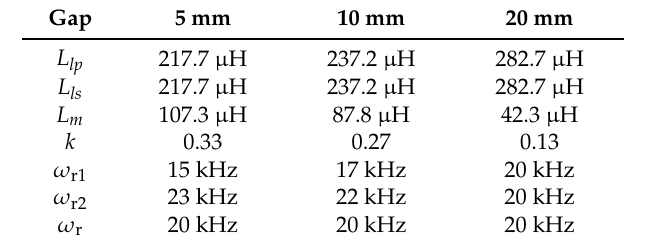
Table 1. Coupling coefficient and resonant frequency of the IPT system with varied air gap.